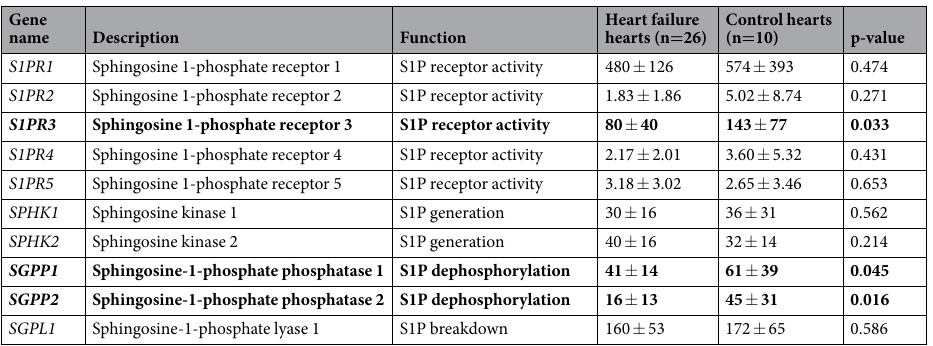
Table 4. mRNA expression levels of S1P-related genes involved in S1P pathway in heart failure and control hearts. Data are showed as the mRNA expression levels (arbitrary units) ± standard